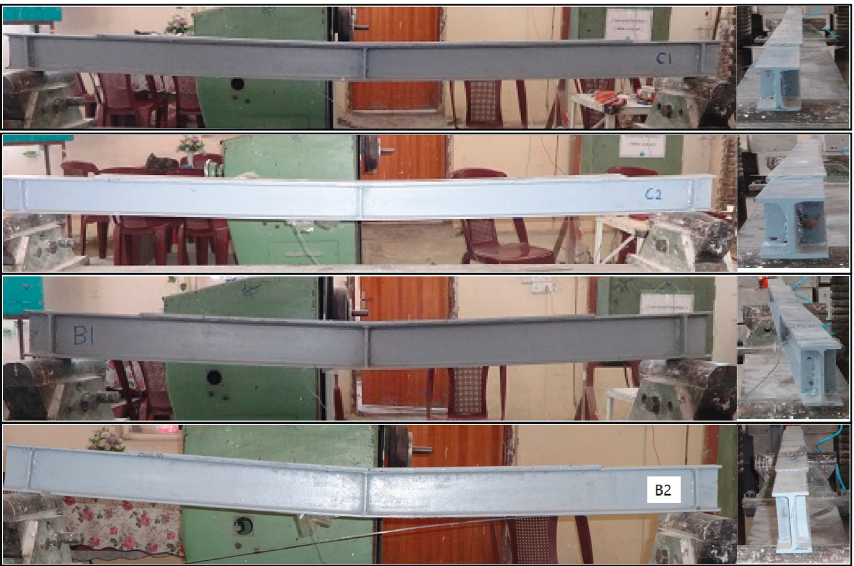
Figure 15: Shapes of failed tested